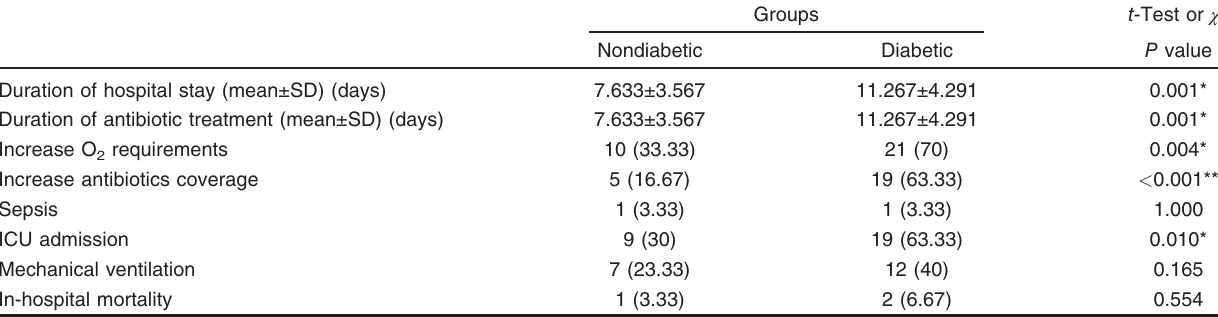
Table 4 Outcomes in nondiabetic and diabetic patients with community-acquired pneumonia